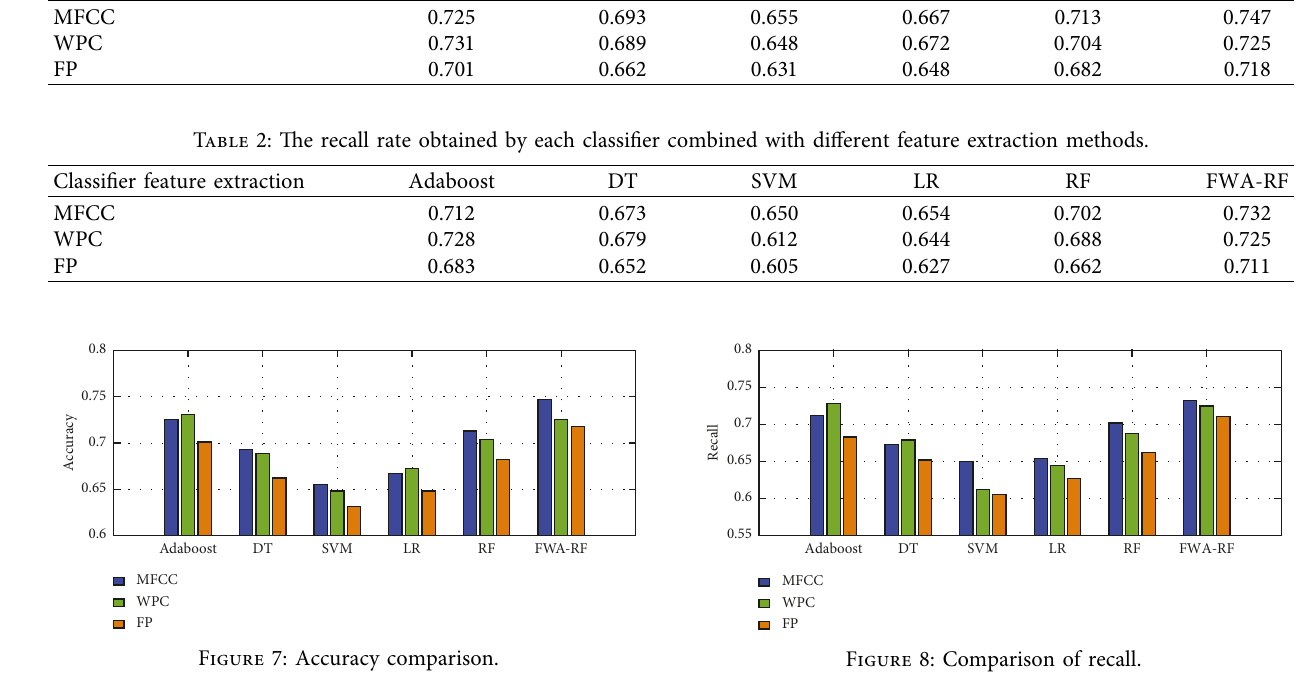
Table 1: Accuracy obtained by each classifier combined with different feature extraction methods. Classifier feature extraction